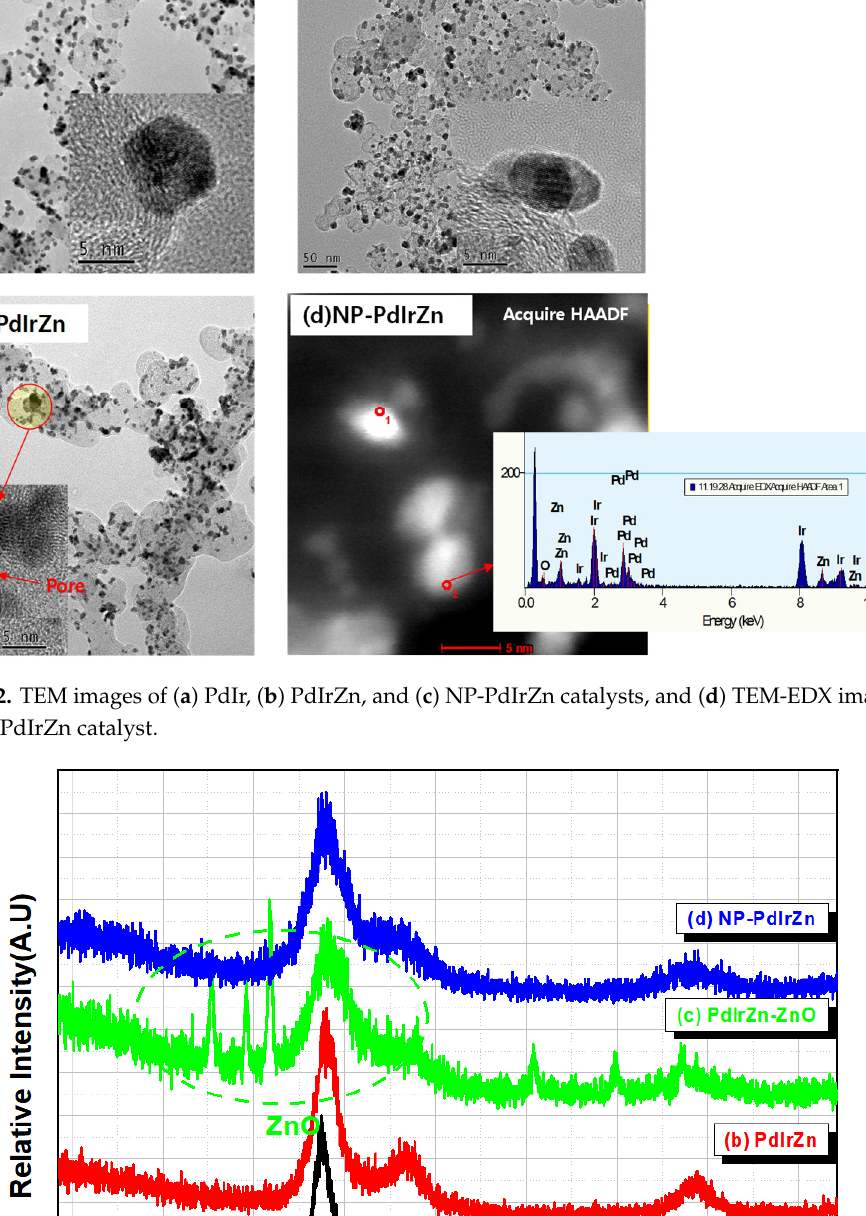
Table 1. ICP analyses of PdIr, PdIrZn, PdIrZn-ZnO, and NP-PdIrZn catalyst. Catalyst